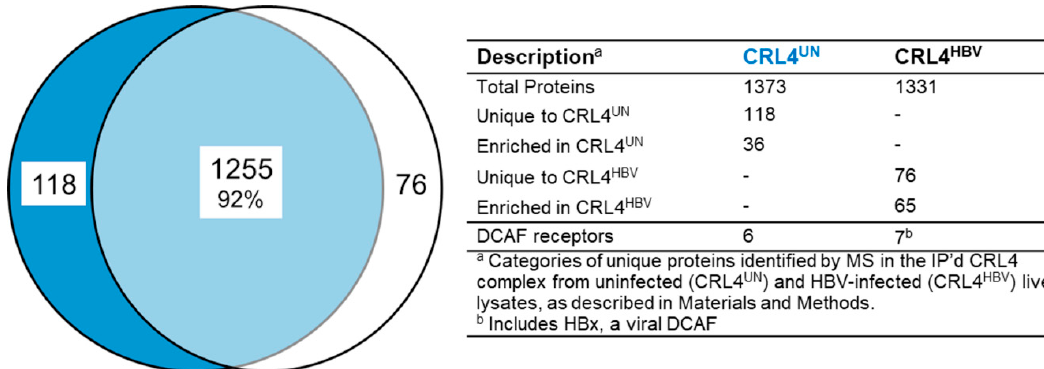
Figure 2. Comparison of CRL4-associated proteins from uninfected and HBV-infected liver tissue: A comparison of the 1373 proteins identified in CRL4 UN with the 1331 proteins in CRL4 HBV (Supplementary Table S3) revealed that 1255 (92%) of the proteins were present in both complexes. There were 118 proteins found only in the CRL4 UN and 76 were only in CRL4 HBV (Supplementary Table S4). Proteins identified in each IP were assigned an intensity-based absolute quantification (iBAQ) value (described in the Materials and Methods section) and then normalized to CUL4 levels to determine their relative abundance in the complex. Other proteins were enriched in CRL4 UN (n = 36) or the CRL4 HBV (n = 65) (Supplementary Table S5a,b). Among the 118 proteins unique to CRL4 UN was SMC6, previously described as an HBV restriction factor